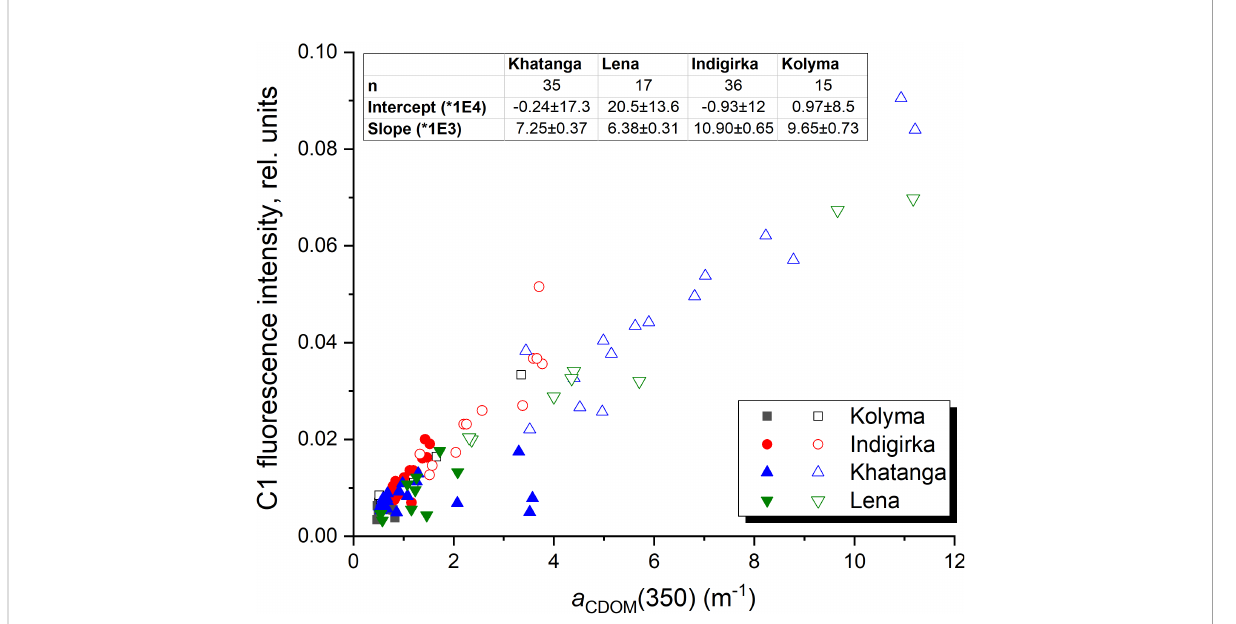
FIGURE 9 Fluorescence intensity of C1 against CDOM absorption coef fi cient at 350 nm. Filled symbols indicate the data obtained outside the river plume regions with salinity above 27.